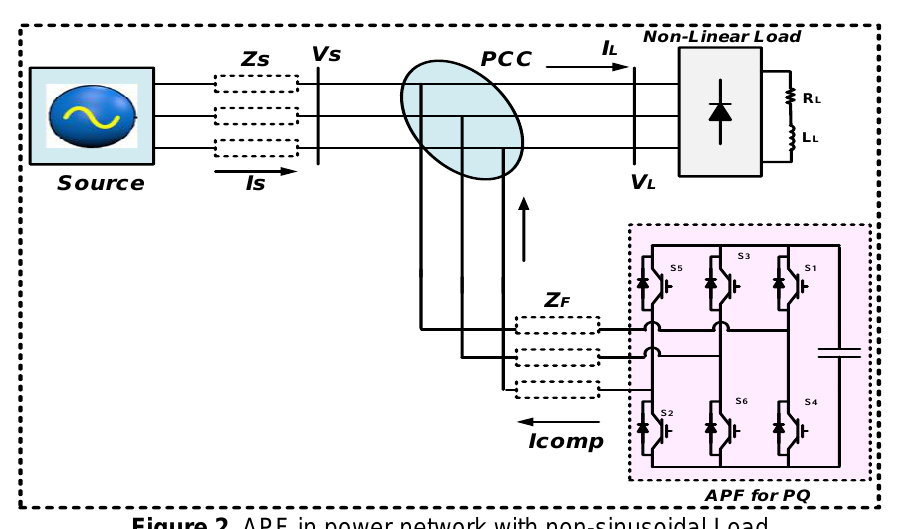
Figure 2. APF in power network with non-sinusoidal